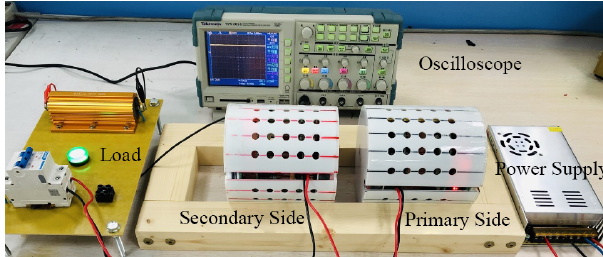
Figure 14. Prototype of the wireless power transfer device.